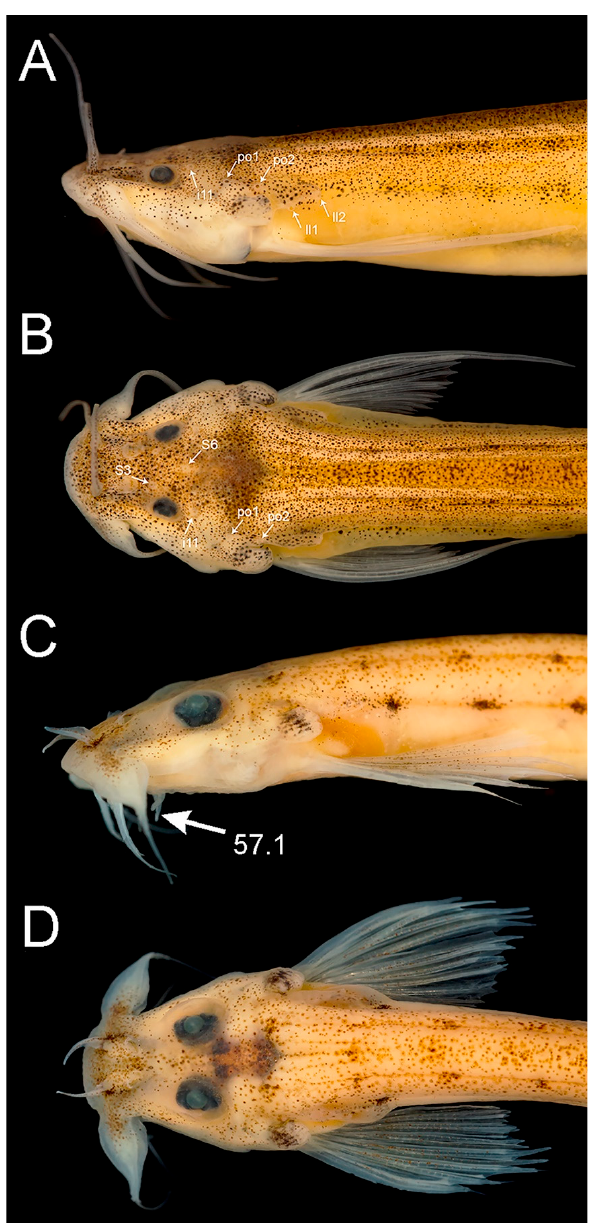
Figure 9. Head and anterior portion of trunk: ( A , C ), left lateral view, ( B , D ) dorsal view, of: ( A , B ) Microcambeva ( Trichocambeva ) filamentosa , UFRJ 12187, 31.4 mm SL, ( C , D ) Microcambeva ( Pterocambeva ) ribeirae , UFRJ 12189, 33.3 mm SL. Modified from (17): Figure 3. The numbers are characters, followed by character states after dots, which are numbered according to Appendix C.